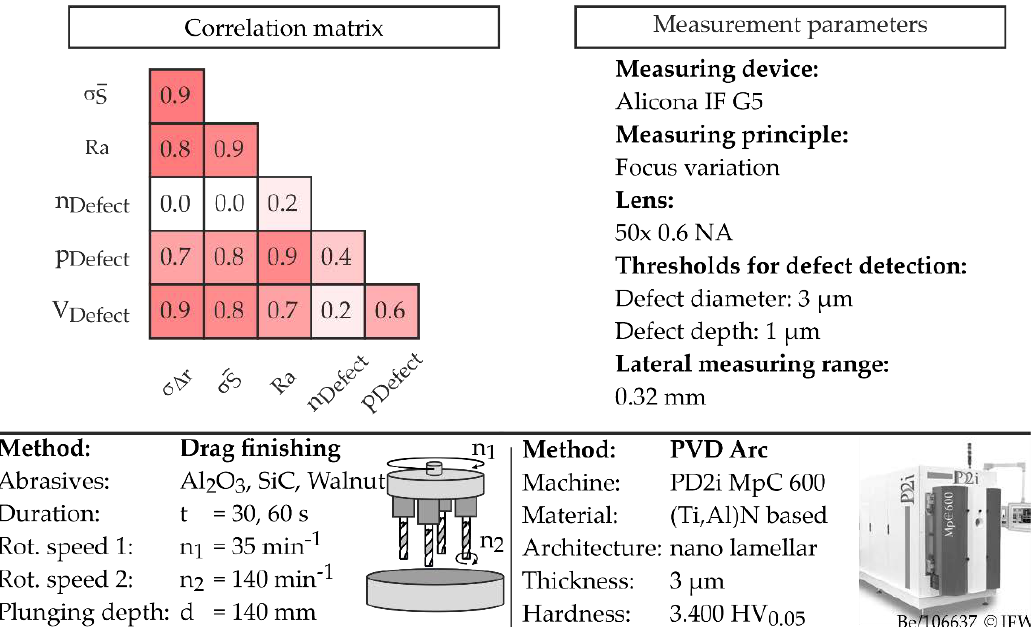
Figure 10. Correlation of different parameters for the description of the chipping.